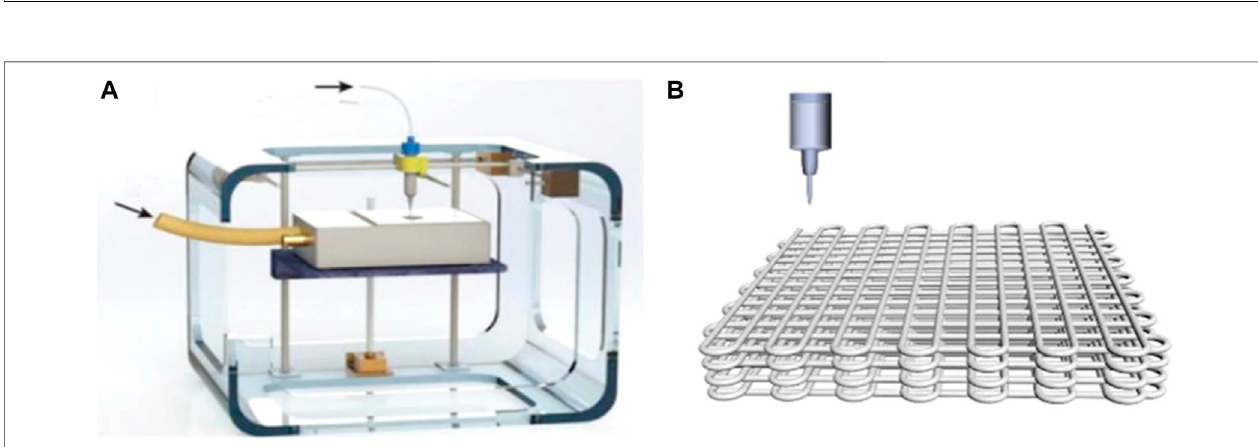
FIGURE 11 | (A) Schematic of the 3D “ drop-on-demand ” ink jet printer.Copyright 2019, Elsevier. (B) Schematic illustration of 3DP-Zn-E. Copyright 2019, Advanced Functional Materials.